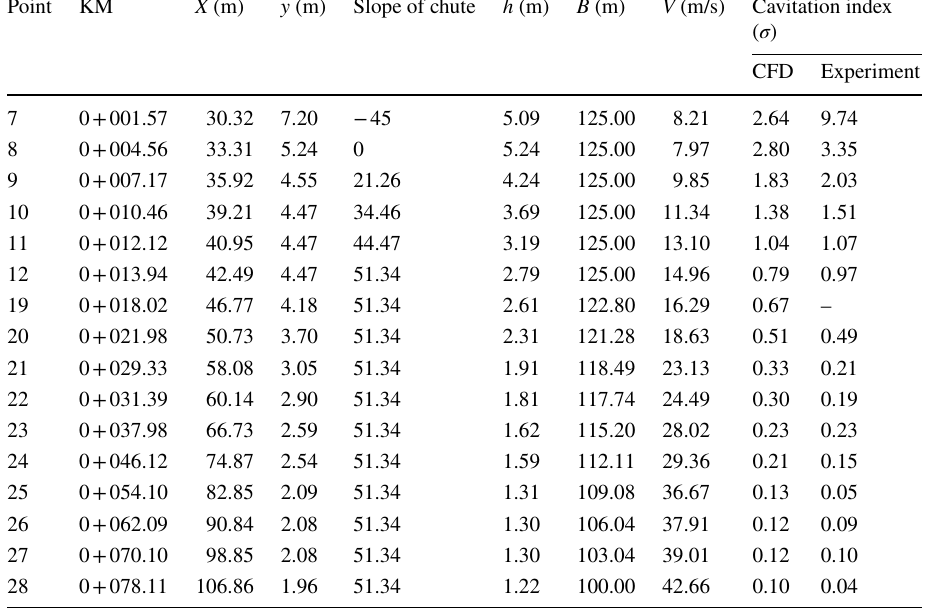
cavitation Index